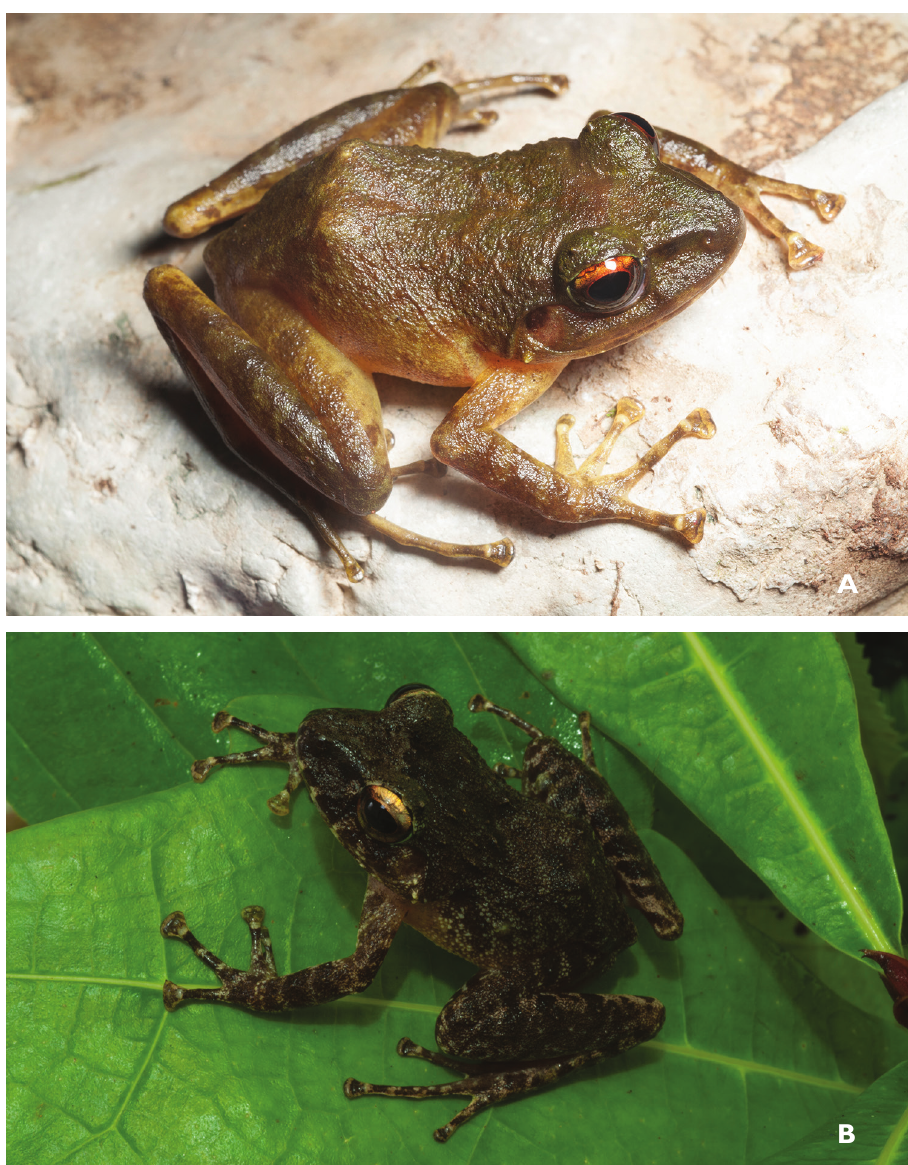
Figure 5. Platymantis guentheri male ( A KU 309208) from Eye Falls, Mt. Hilong-hilong, Municipality of Remedios T. Romualdez, Agusan del Norte Province. Photo: RMB; ( B KU 333494) from Mt. Mam- bajao, Municipality of Mambajao, Camiguin Sur Island. Photo: